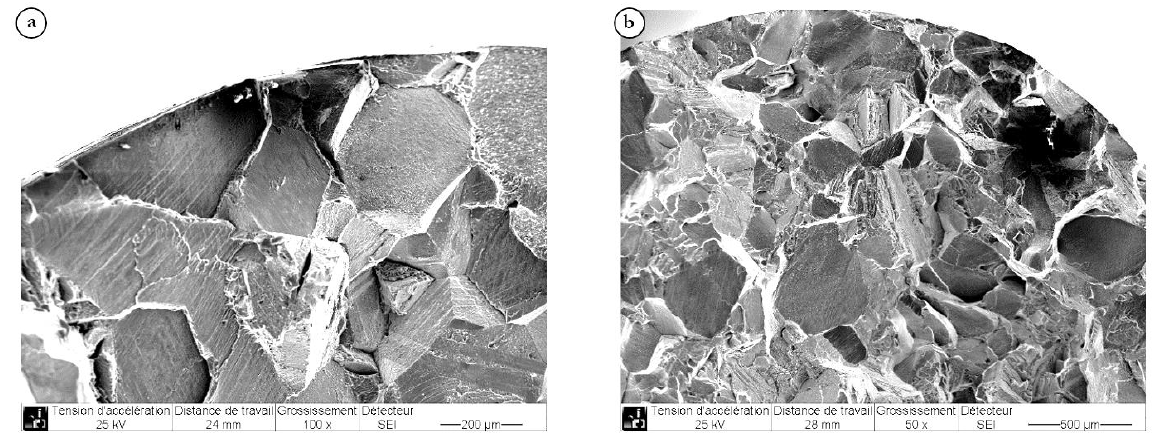
Figure 10. SEM fracture surface observations of crept specimens at 700 °C: coarse grains microstructure; ( a ) 600 MPa, ( b ) 850